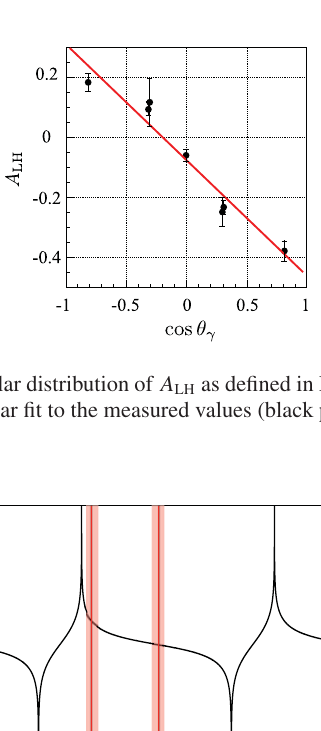
Figure 10. The variation of the neutron polarization, transmis- sion, and FOM as a function of the amount of 3 He for 0.74eV neutrons, evaluated for a 3 He polarization of 70%.